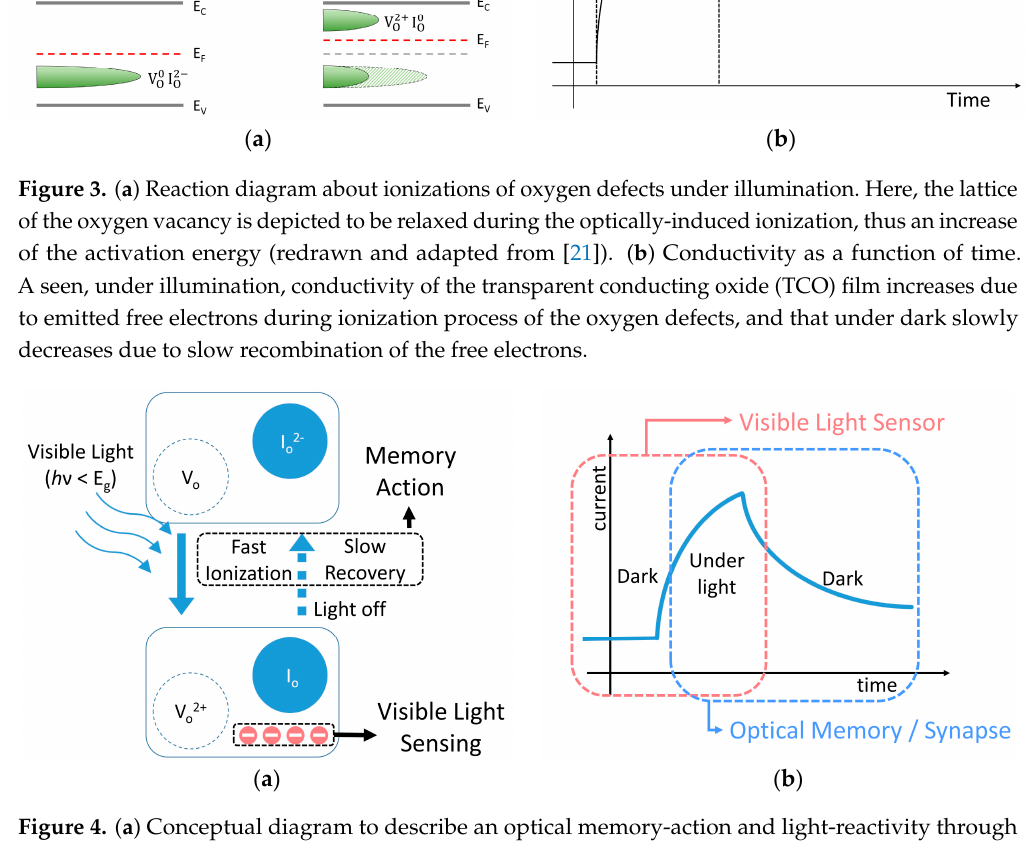
( b ) Figure 5. ( a ) Conceptual plot of the drain current of the TCO-based optical device. Here, the positive gate pulse makes dark signal level after illumination as same as the level before illumination as illustrated in this figure. ( b ) Energy band diagram of the device when positive gate pulse is applied.